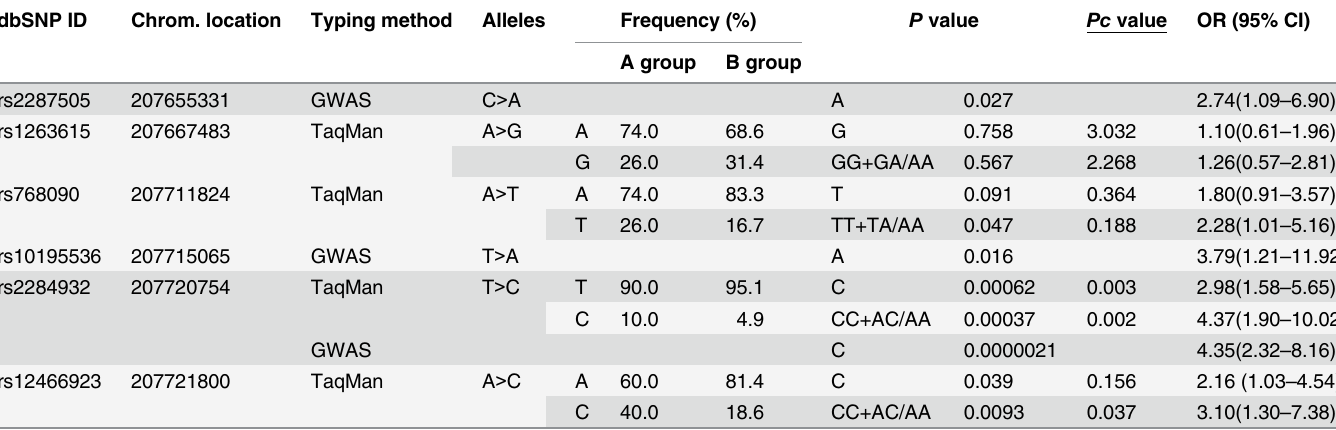
Table 3. Association analysis of single nucleotide polymorphisms in the KLF7 gene. dbSNP ID